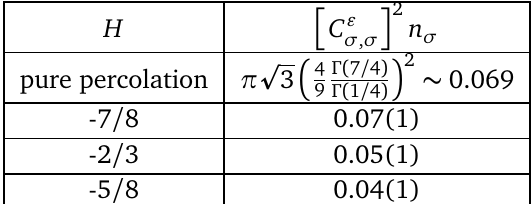
Table 4: Estimation of the coefficient computed in [ 50 ]